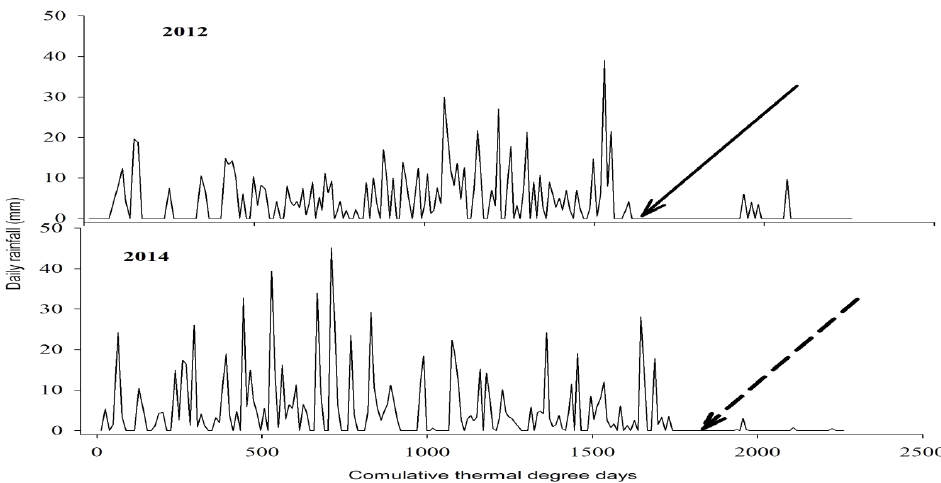
Figure 2. Daily rainfall (mm) versus cumulative thermal degree days (DD) at the Bako Agricultural Research Center, Ethiopia, for the 2012 and 2014 cropping seasons. Note: the solid line indicates cessation of rainfall for 31 days during pod setting (2012), whereas the dashed line (2014) indicates cessation at the time near physiological maturity.